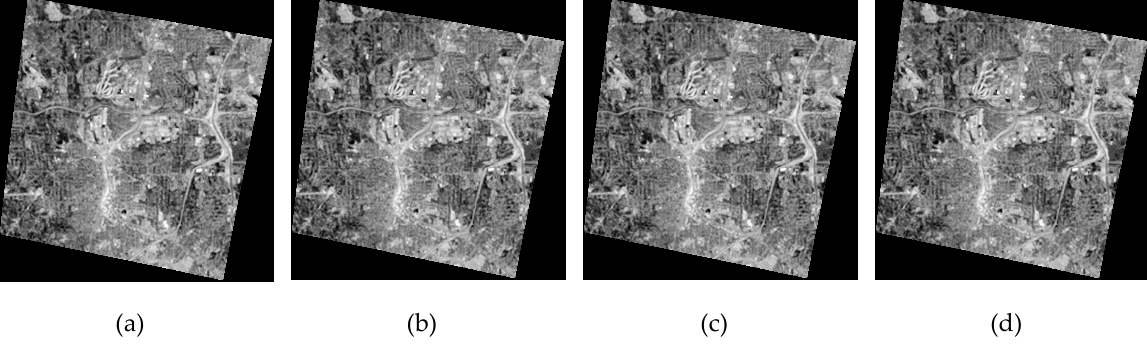
Figure 23. The georeferenced image of the second data set. ( a ) By FPGA. ( b ) By MATLAB. ( c ) By Visual Studio (C++). ( d ) By ENVI 5.3.